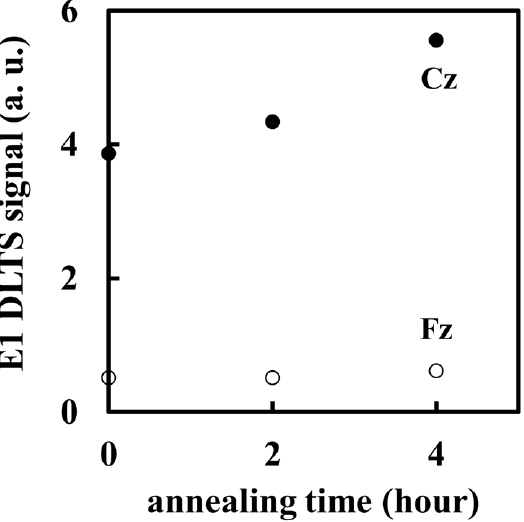
Figure 4. The relationship between annealing time and E1 defect concentrations.